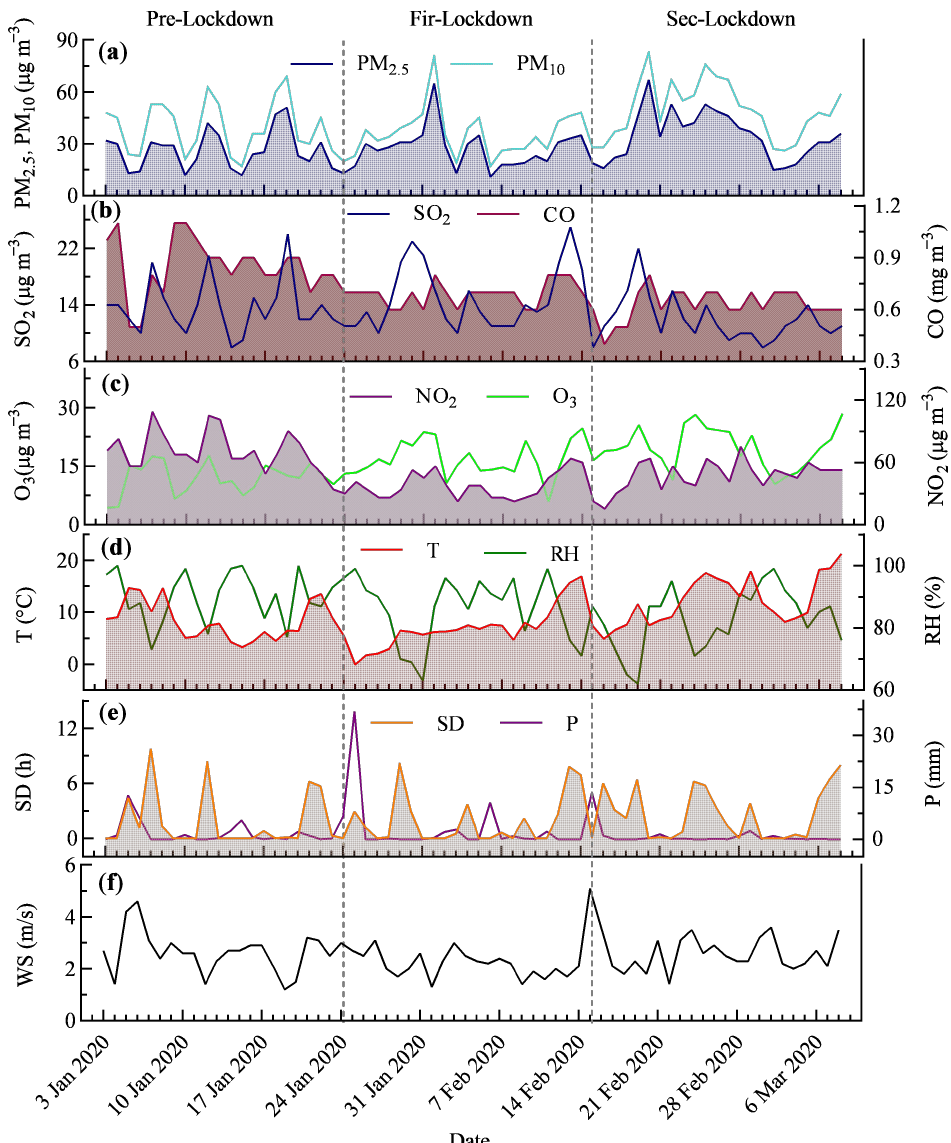
Figure 3. Daily mean pollutant concentrations and meteorological parameters from 3 January 2020 to 8 March 2020 in Guiyang city. ( a ) PM 2.5 , PM 10 , ( b ) SO 2 , CO, ( c ) NO 2 , O 3 , ( d ) T: temperature, RH: relative humidity, ( e ) SD: sunshine duration, P: precipitation, ( f ) WS: wind speed. The hourly mean concentration of PM 2.5 during the Fir-Lockdown period was com- parable with that during the Pre-Lockdown period, but the hourly mean concentration of PM 10 in the daytime (11:00–20:00) during the Fir-Lockdown period was significantly lower. These results show that COVID-19 lockdown significantly reduced the PM 10 concentration